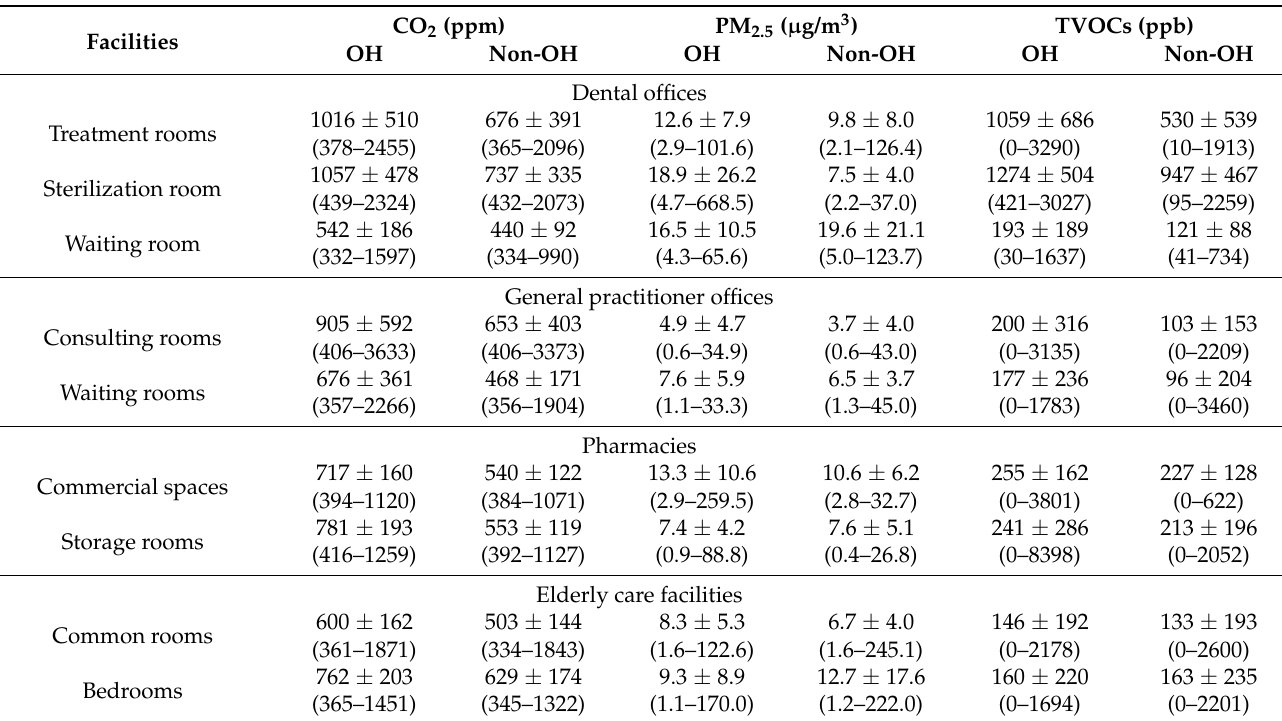
Table 1. Comparison of mean ± SD (min–max) concentrations of CO 2 , PM 2.5 and TVOCs measured in different rooms of private healthcare and elderly care facilities according to the occupancy hours (OH) and non-occupancy hours